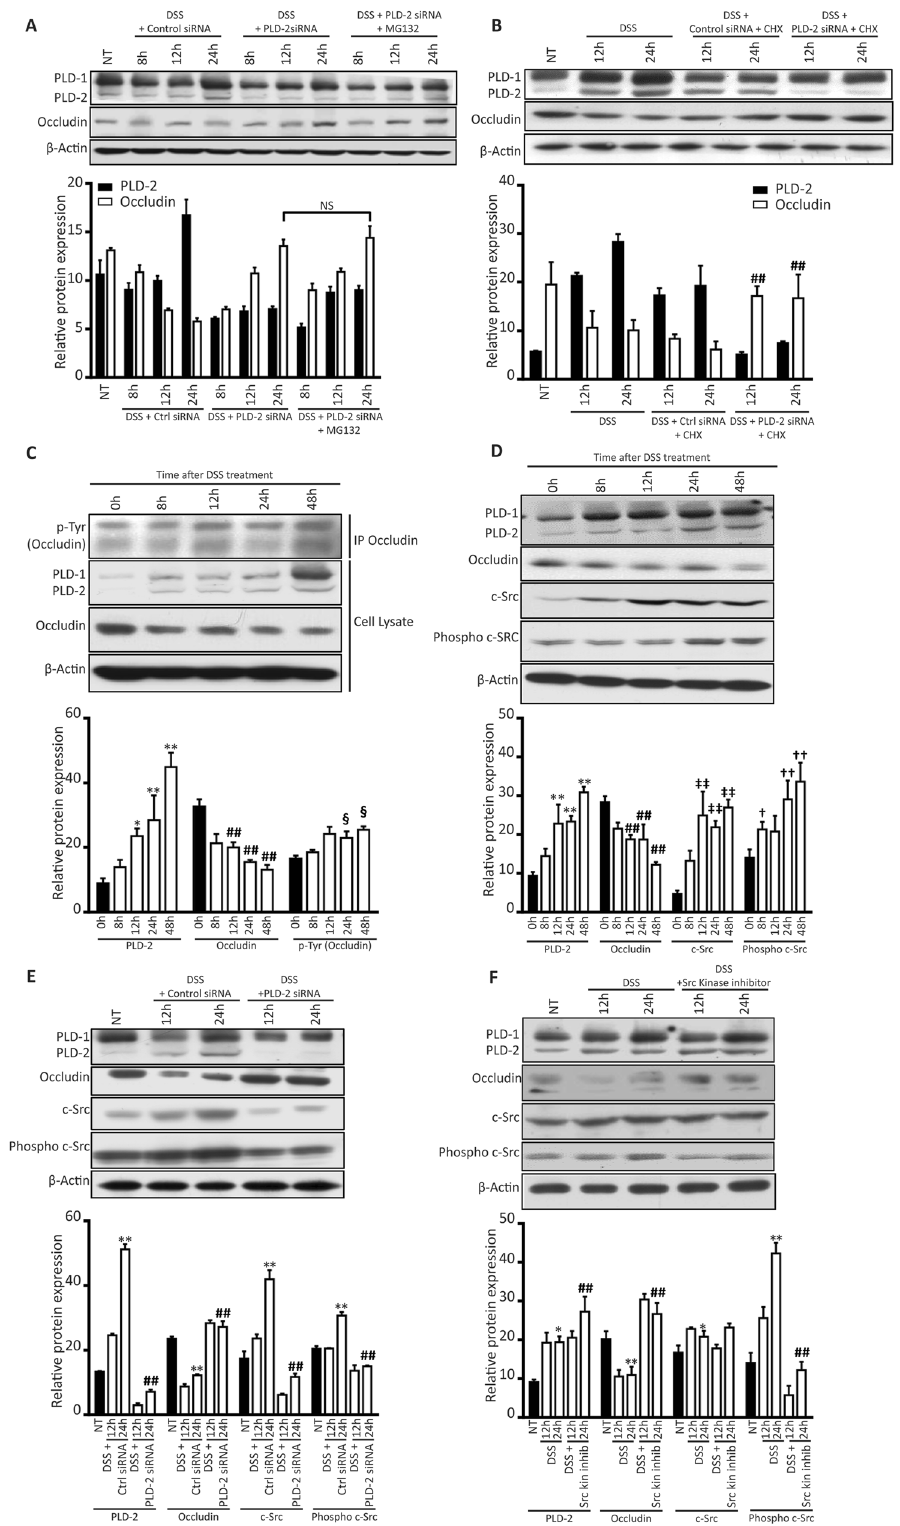
Figure 5. PLD2 regulates occludin levels by mediating the proteasome-mediated degradation of occludin via a Src kinase-dependent pathway. ( A ) HT-29 cells transfected with PLD2 siRNA were treated with 2% DSS and 10 nM MG132 to inhibit protein degradation; PLD2 and occludin expression were analysed by western blotting at the indicated time points. ( B ) HT-29 cells, transfected with control PLD2 siRNA, were treated with 2% DSS and 10 µ g/mL cycloheximide (CHX) to inhibit protein degradation; PLD2 and occludin expression were analysed by western blotting at the indicated time points. ( C ) Occludin was immunoprecipitated after HT-29 colon epithelial cells were treated with 2% DSS; cell lysates were immunoblotted for phospho-tyrosine to